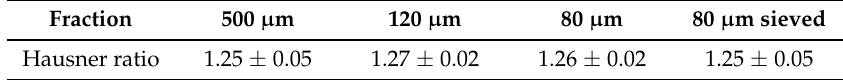
Table 2. Hausner ratios calculated from the density measurements of each rotor milling step.